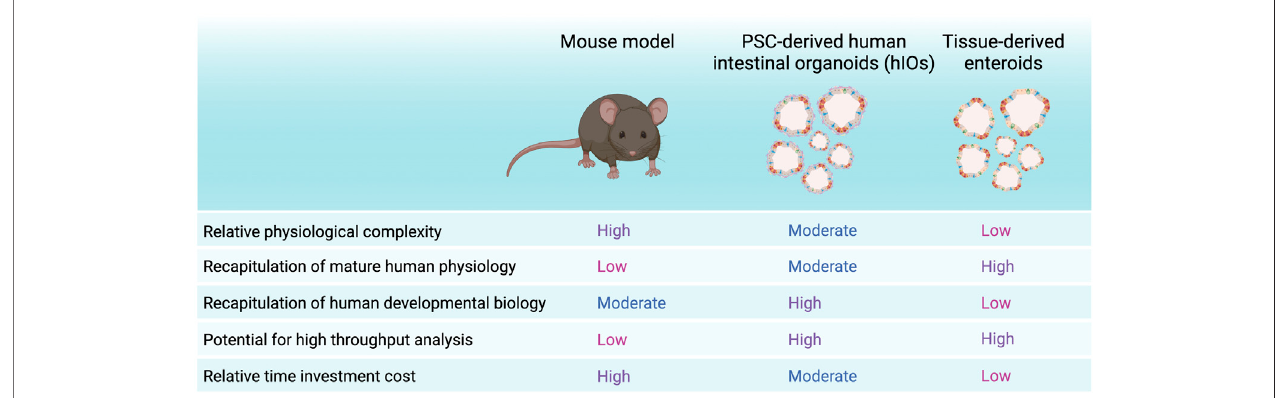
FIGURE 2 | Strengths and weaknesses of hIOs, enteroids and mouse models. Summary of advantages and disadvantages of PSC-derived organoids or hIOs, tissue-derived organoids or enteroids and the mouse model. Created with BioRender.com.